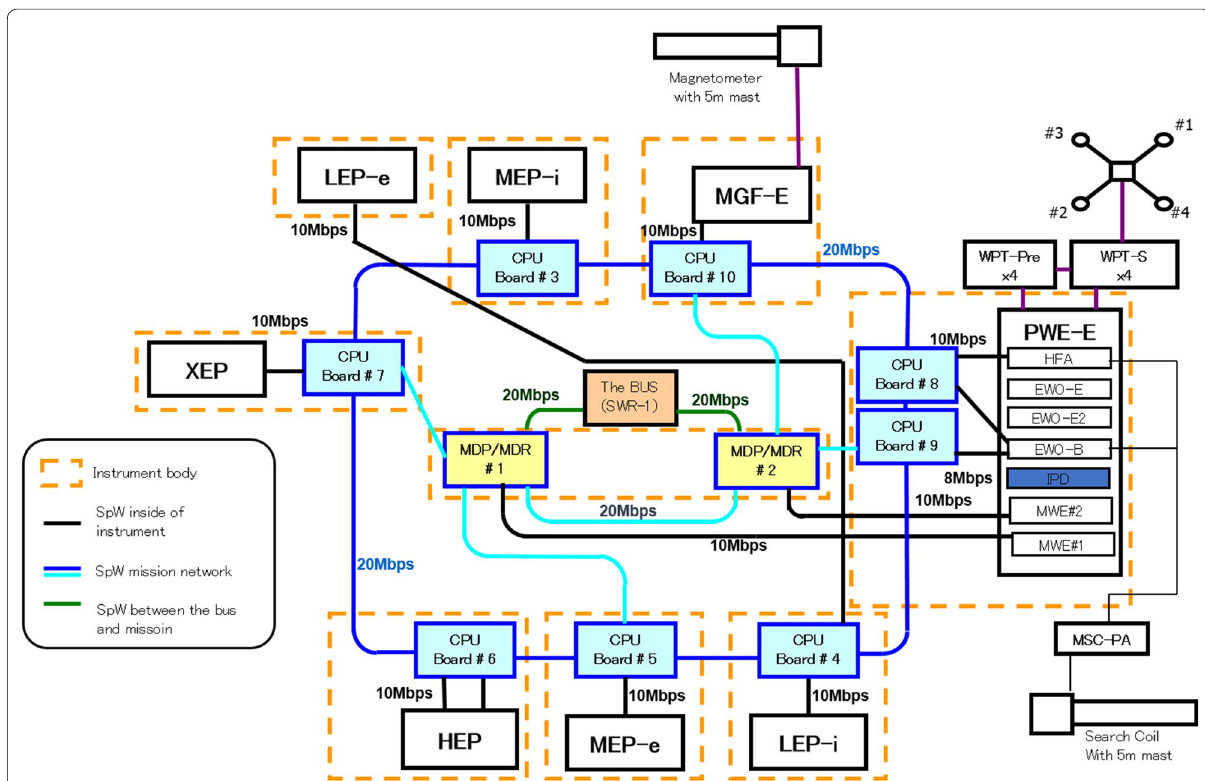
Fig. 4 The mission network of physical connections with SpaceWire. The blue line is the ring network connecting each instrument (CPU board) by SpaceWire. The sky-blue lines indicate paths from the ring network to MDPs. The green lines are SpaceWire interfaces between the bus (SWR-1) and the mission (MDP1 and MDP2)